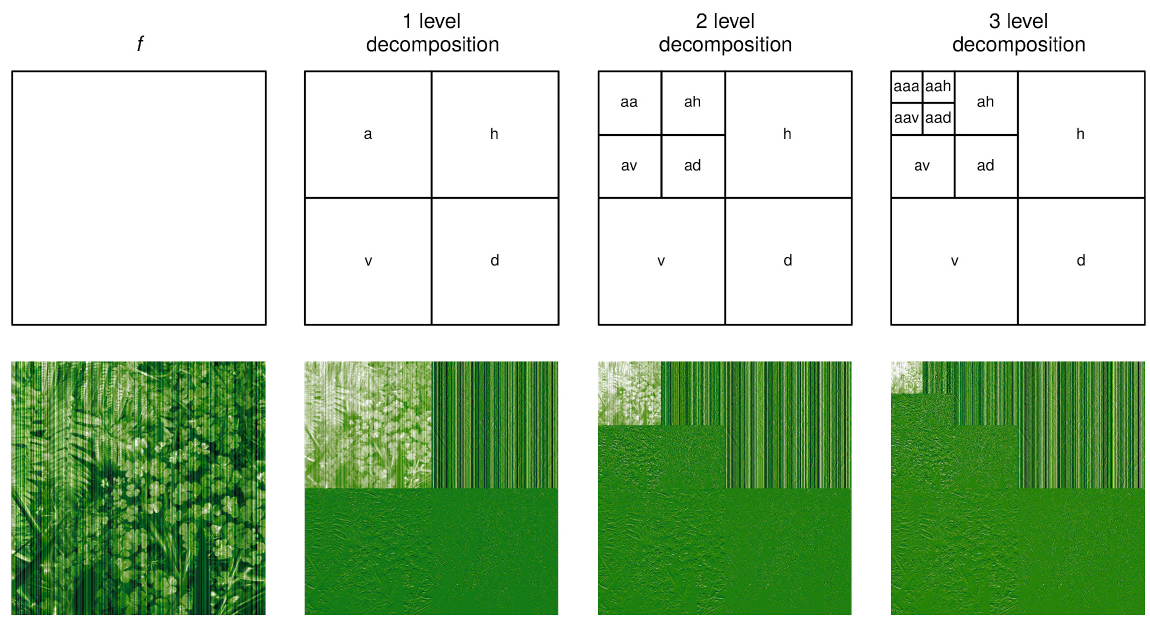
Figure 14. 2D wavelet decomposition of an image with vertical stripes for different decomposition levels. The low-pass approximation coefficients a l still contain the self-similar complete signal information at a lower resolution; the other bands contain the details to reconstruct the higher-resolution image. The striping information is concentrated in the detail bands represented by the coefficients h l .